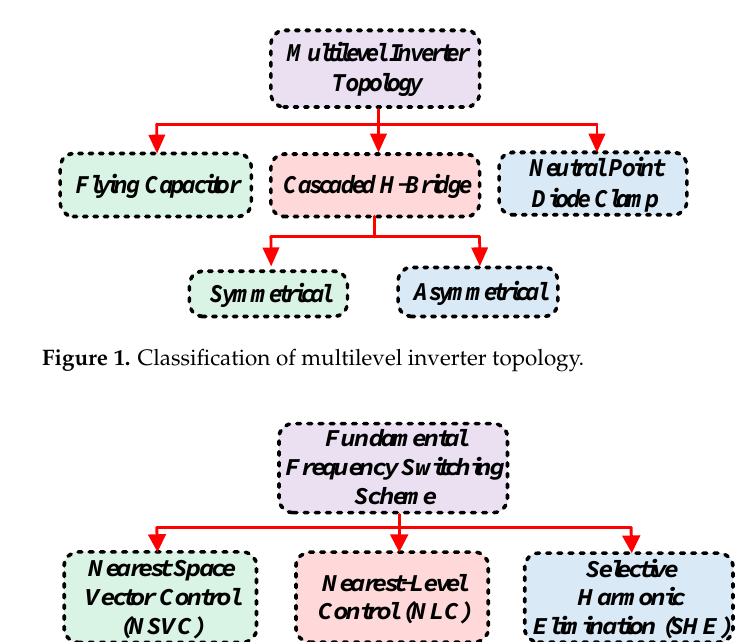
Figure 2. Classification of fundamental switching frequency techniques.